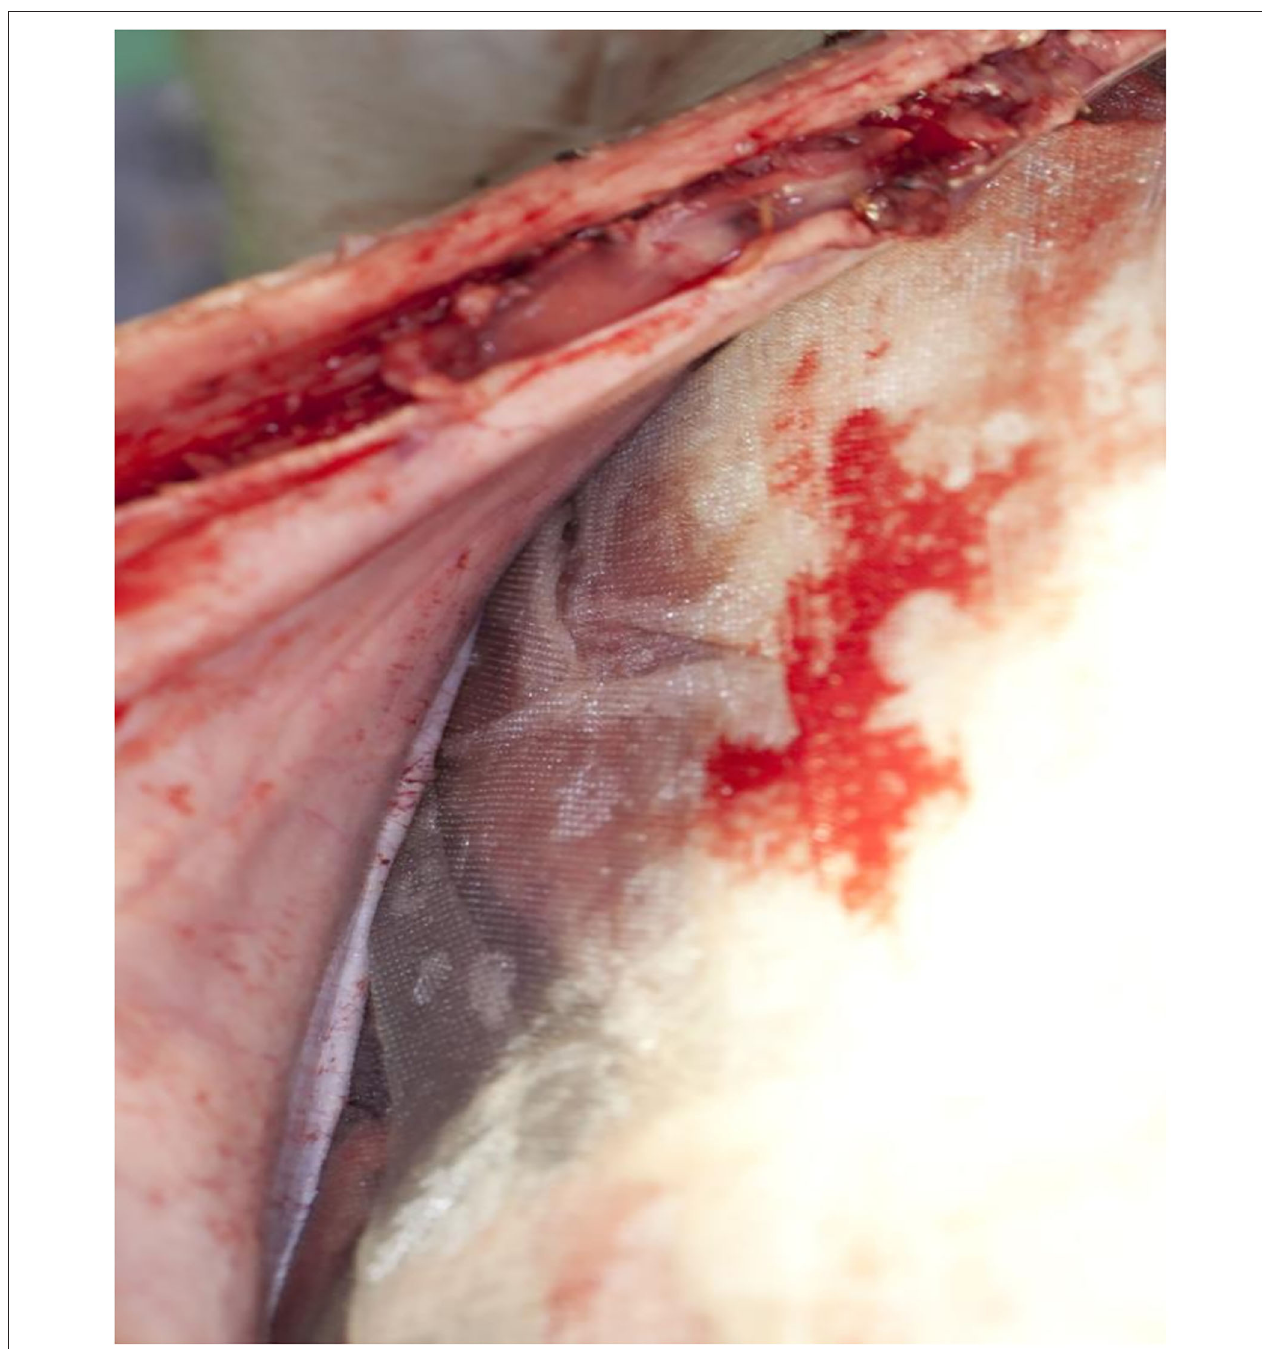
FIGURE 3 | The Suprasorb-CNP film easily detached from the abdominal wall.